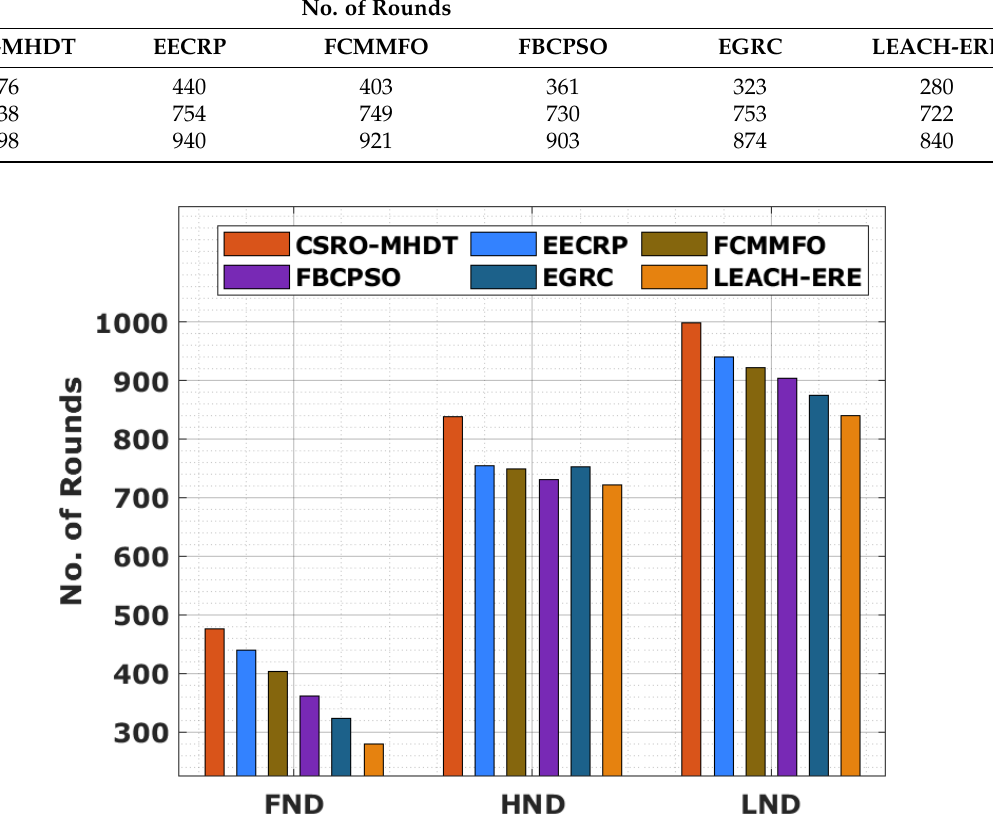
Figure 4. Network lifetime analysis of the CSRO-MHDT technique in comparison with existing approaches.